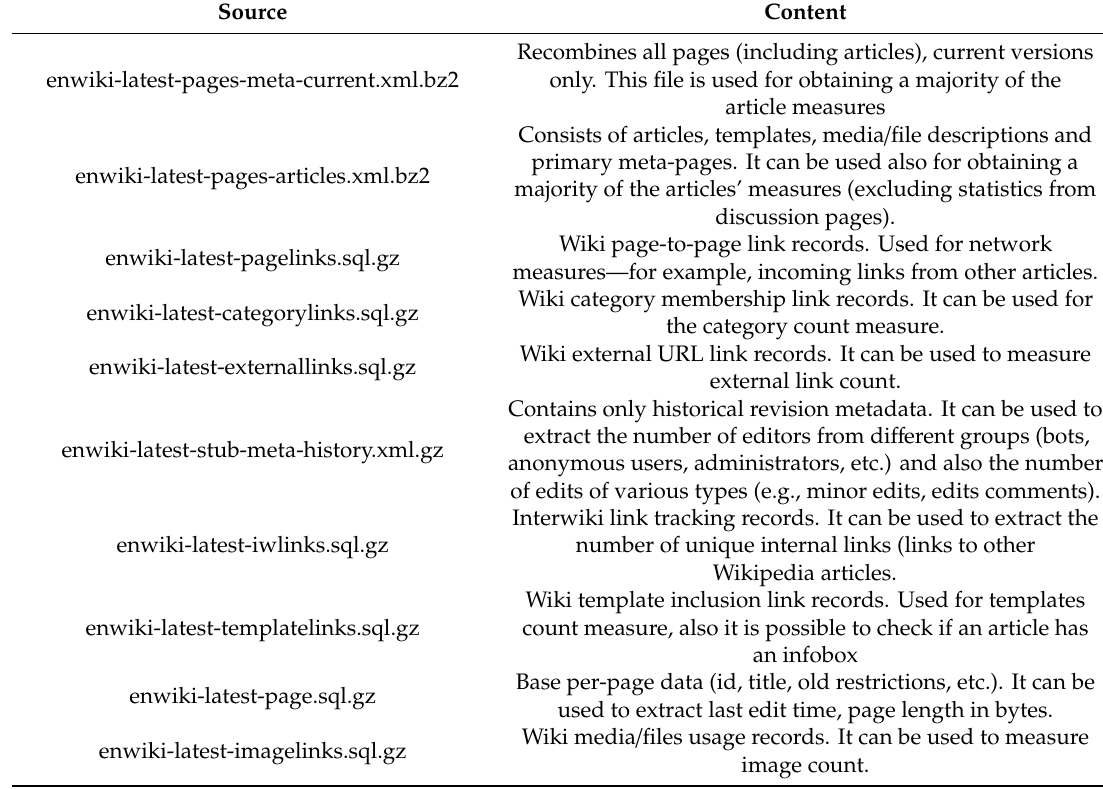
Table 1. Parameters of Wikipedia persisted in database